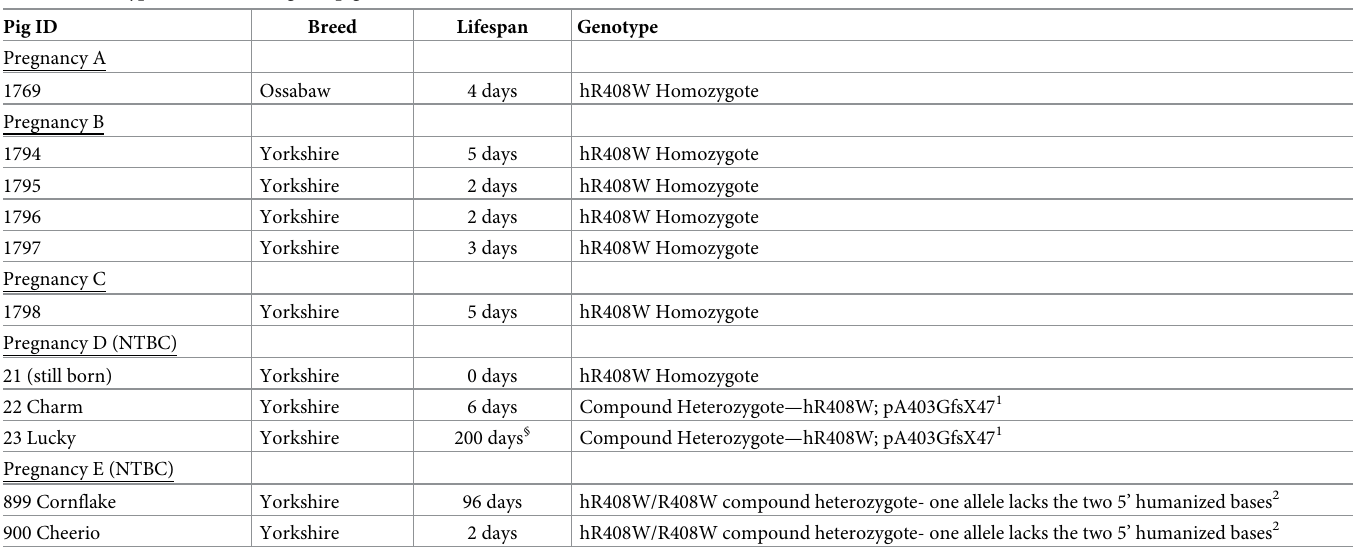
Table 1. Genotypes of all PAH -targeted